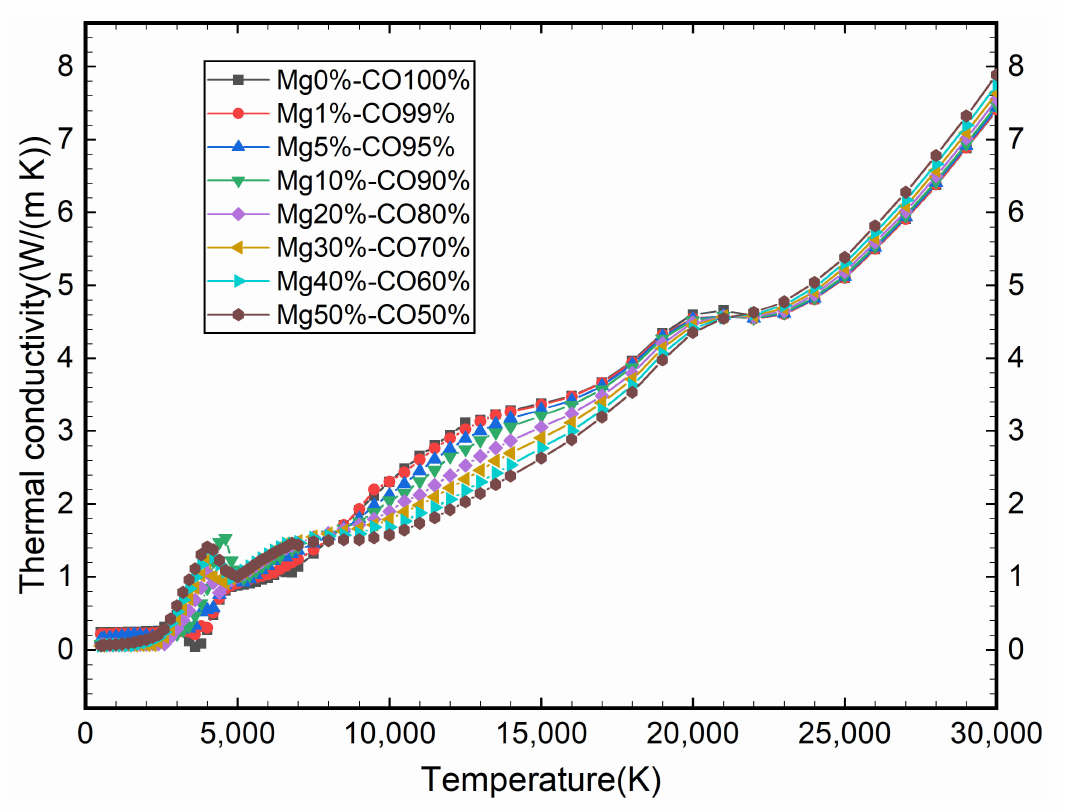
Figure 11. The curves of thermal conductivities for different proportion Mg-CO mixtures plasma at a temperature of 300–30,000 K and 0.1 Mp.